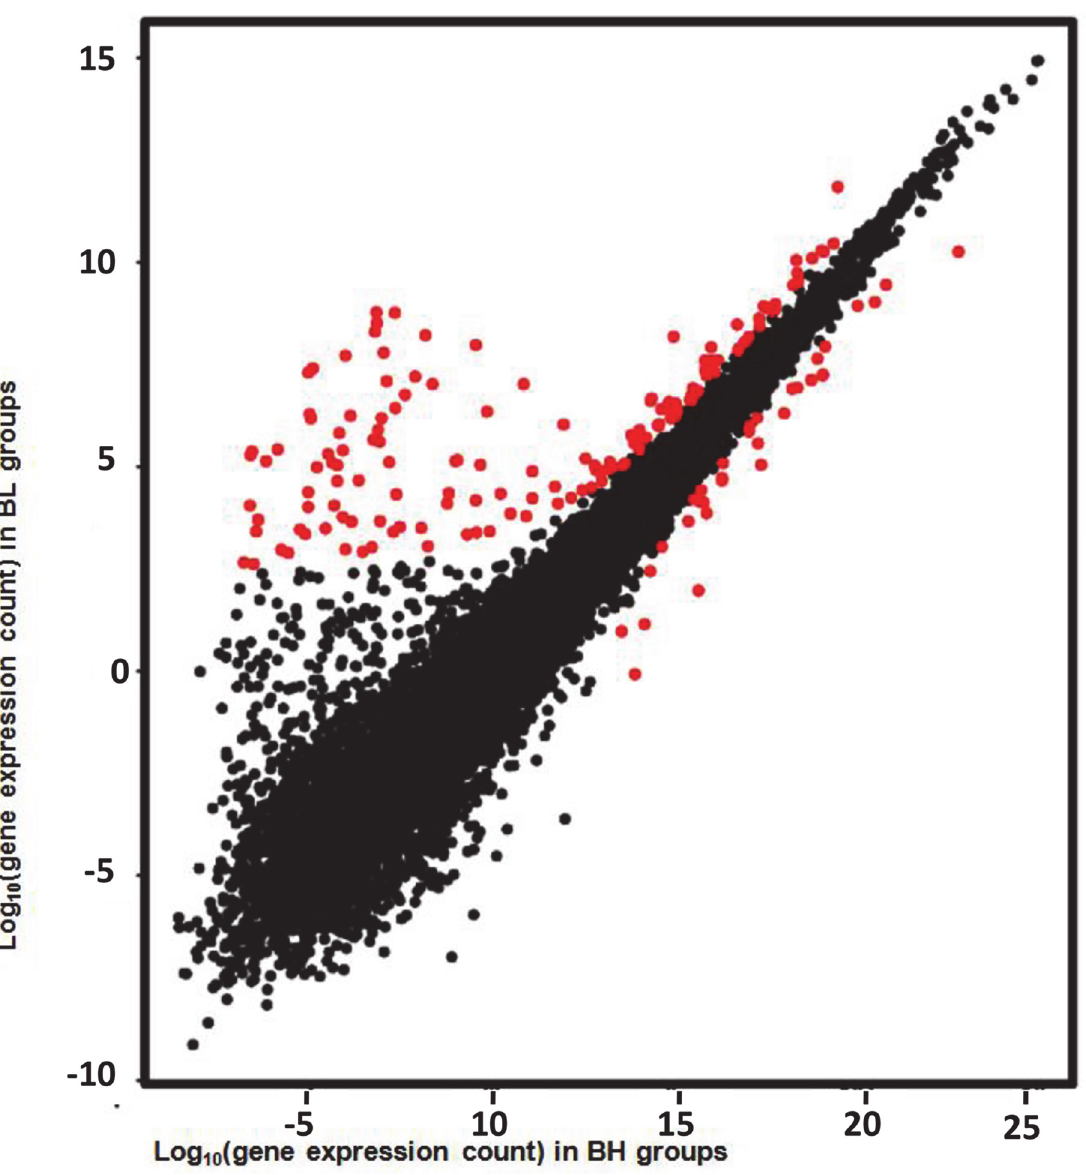
Fig 3. Gene expression level in BH and BL groups. A. X-axis plots gene expression counts in the BH group after TMM quantification and the y-axis plots gene expression counts in the BL group after TMM quantification. The red points indicate significantly differentially expressed